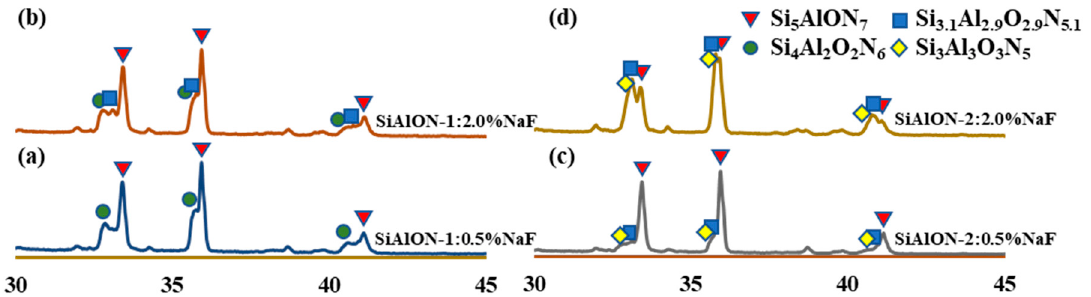
Table 2. Phase composition of the SiAlON:NaF samples after sintering. Sample